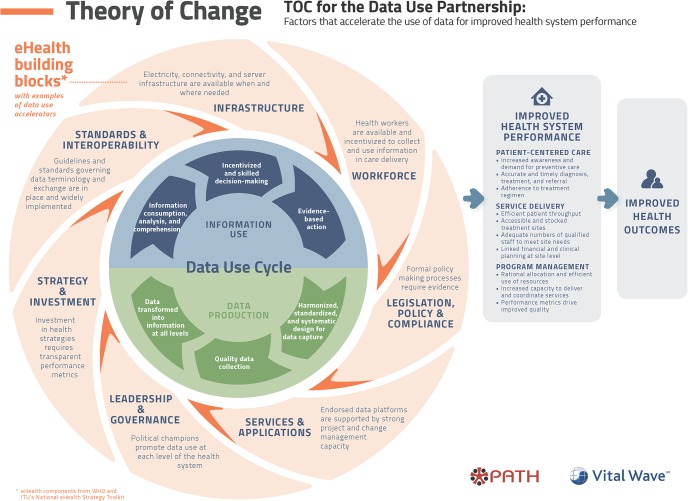
The PATH-Vital Wave Data Use CycleSource: PATH (2016).51